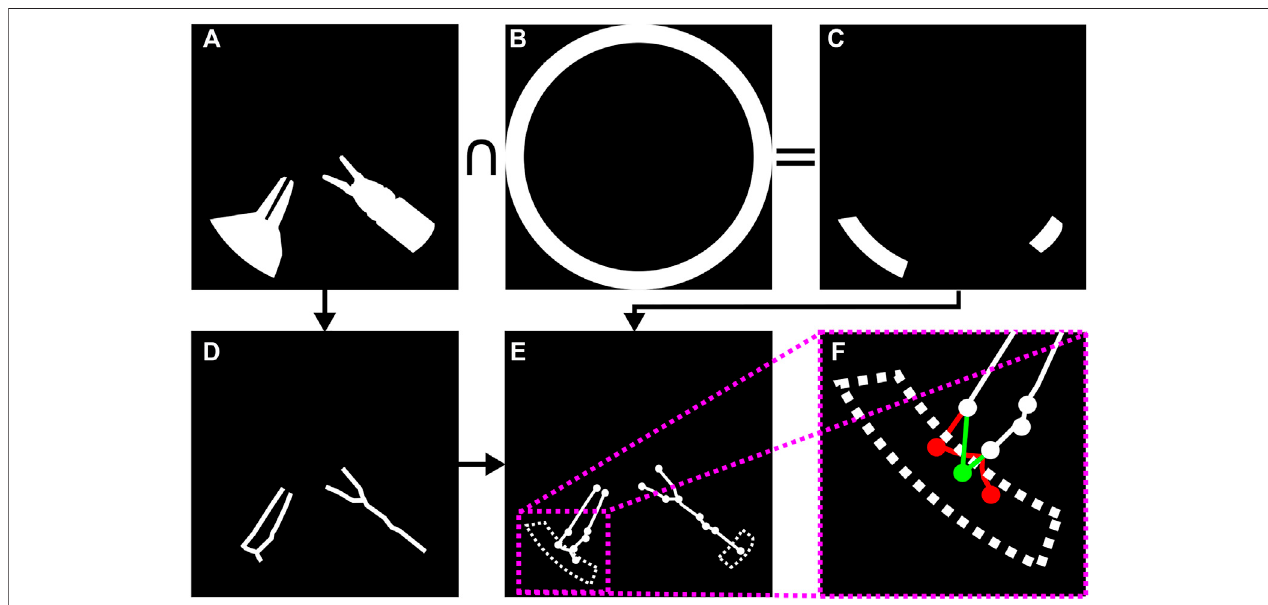
FIGURE5 | Surgical instrument graph construction and entry node extraction: (A) segmentation mask; (B) circle mask used todetect entrypoints; (C) intersection of segmentation mask and circle mask; (D) segmentation mask skeleton obtained according to (Lee et al., 1994); (E) graph obtained from skeleton by means of (Xiaolong, 2019); (F) entrypoint detection. If several graph nodes lie inside the entrypoint mask (in red), they are merged into a new single entry node (in green) whose position attribute is set to the centroid of all the graph nodes inside the dotted area.